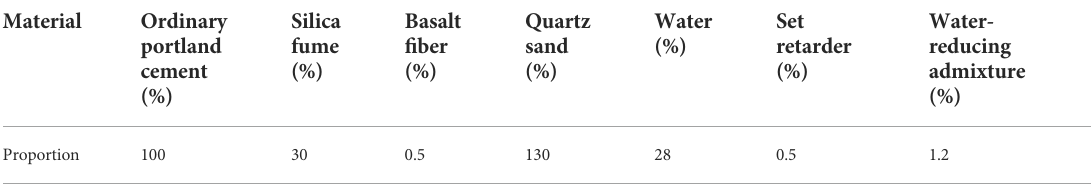
TABLE 1 The ratio of 3D printed concrete materials.